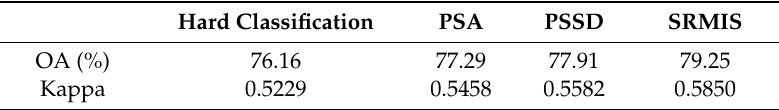
Table 3. Accuracy assessment for the classification results using a Landsat 8 OLI